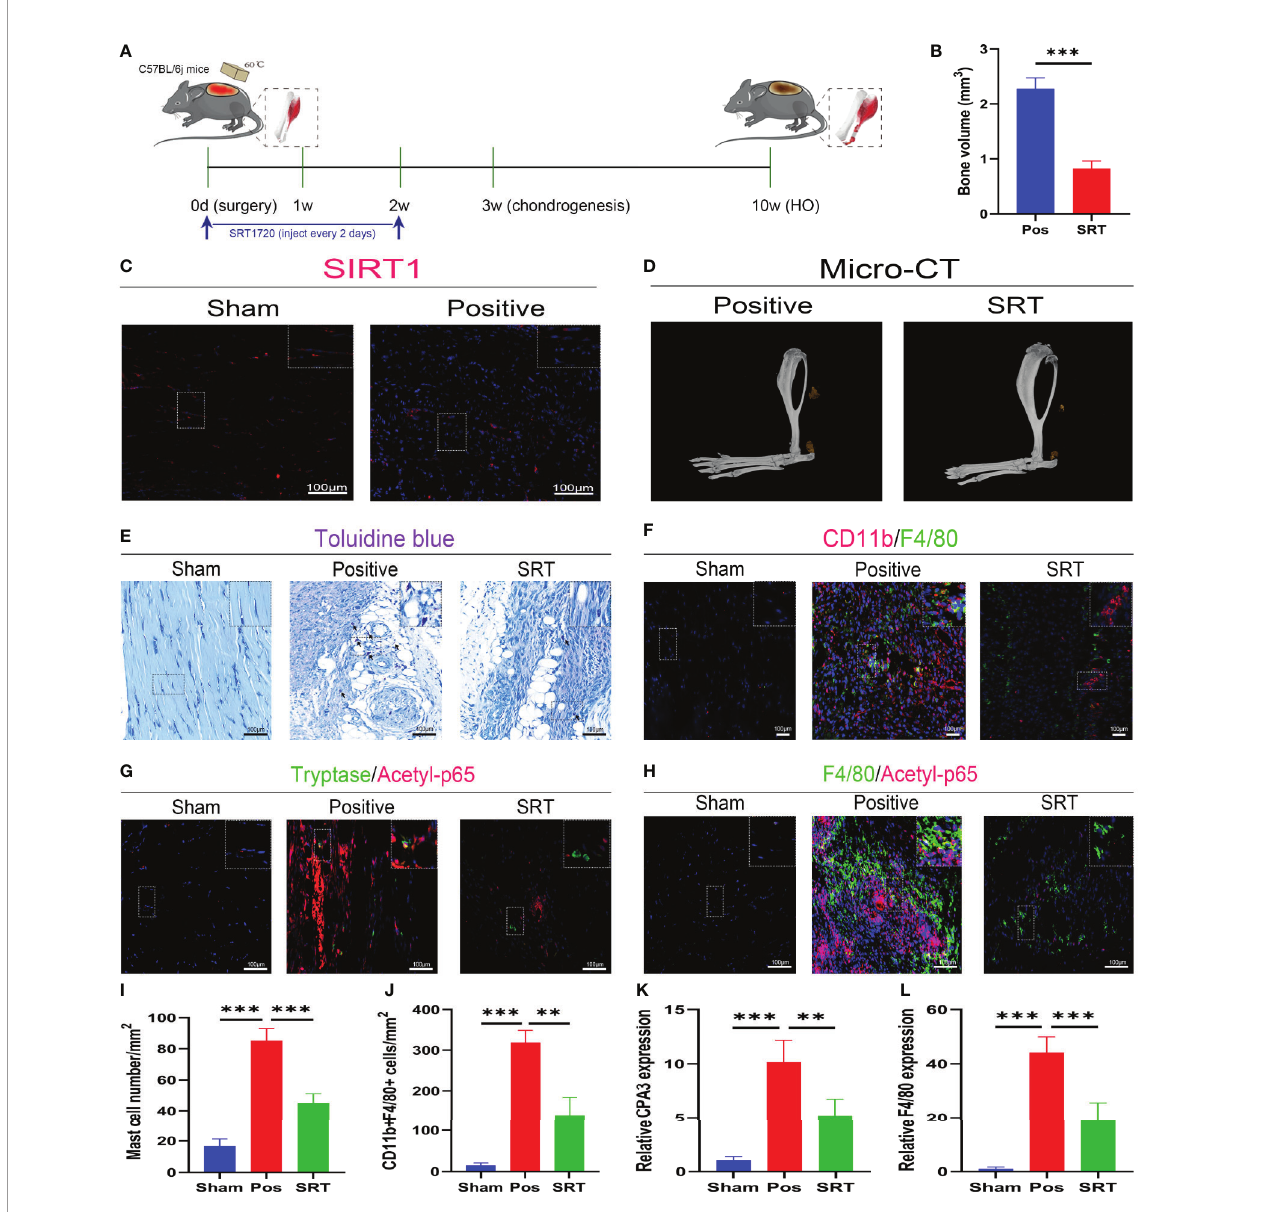
FIGURE 2 | SIRT1/NF k B signaling was responsible for the dysregulated immune responses in trauma-induced HO. (A) Schematic depiction of the agonist treatment protocols for animal experiments. (B, D) Observation and quanti fi cation of HO formation using micro-CT. (C) Fluorescence staining of SIRT1 7 days after burn/tenotomy. (E) Toluidine blue staining for observation of mast cells 7 days after burn/tenotomy. (F) Double fl uorescence staining of CD11b and F4/80 7 days after burn/tenotomy. (G) Double fl uorescence staining of tryptase and acetyl-p65 7 days after burn/tenotomy. (H) Double fl uorescence staining of F4/80 and acetyl- p65 7 days after burn/tenotomy. (I) Quanti fi cation of the mast cells in toluidine blue staining images. (J) Quanti fi cation of CD11b+F4/80+ cells in double fl uorescence staining images. (K) Relative gene expression of the mast cell marker CPA3 as determined by qRT-PCR. (L) Relative gene expression of macrophage marker F4/80 as determined by qRT-PCR. Original magni fi cation is 40x. Inserts are approximately 3.5x magni fi ed images of the boxed area. N=4/group. ***P <